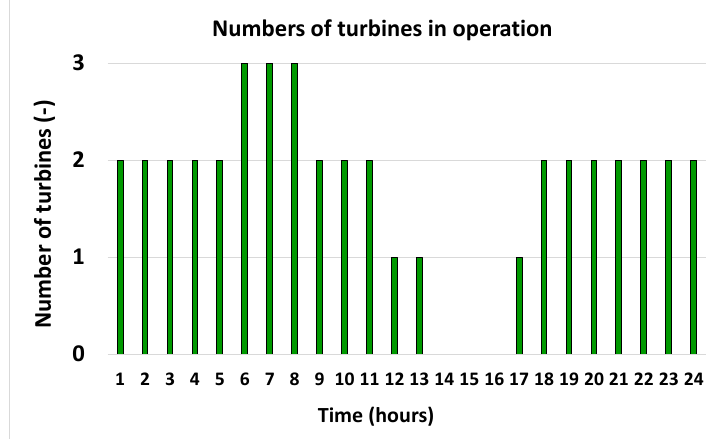
Figure 14. Number of turbines in operation during the representative day.